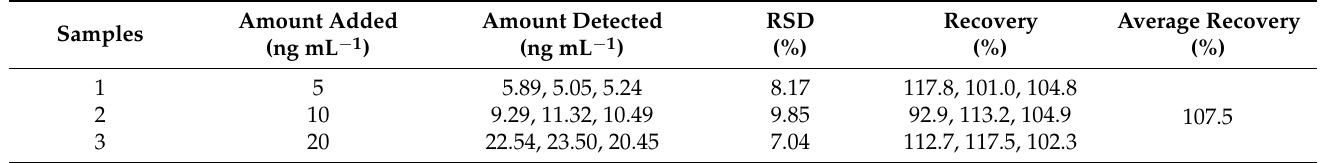
Table 1. Recovery experiment of CRPs in artificial serum